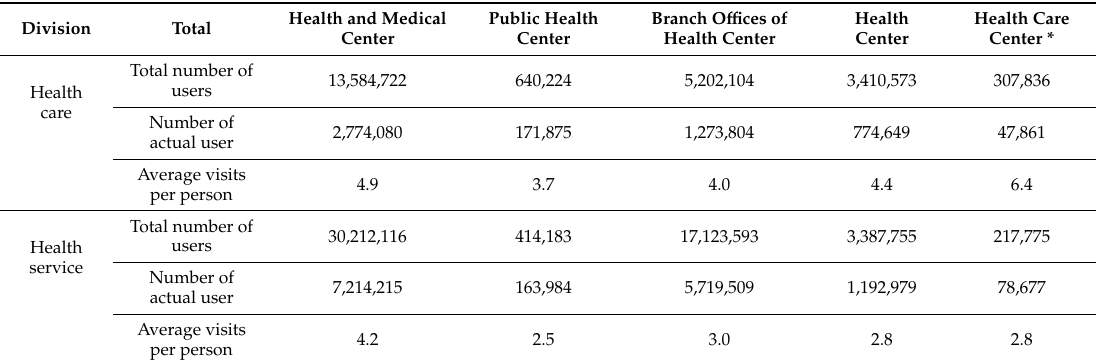
Table 1. Use of local health and medical institutions (2018).